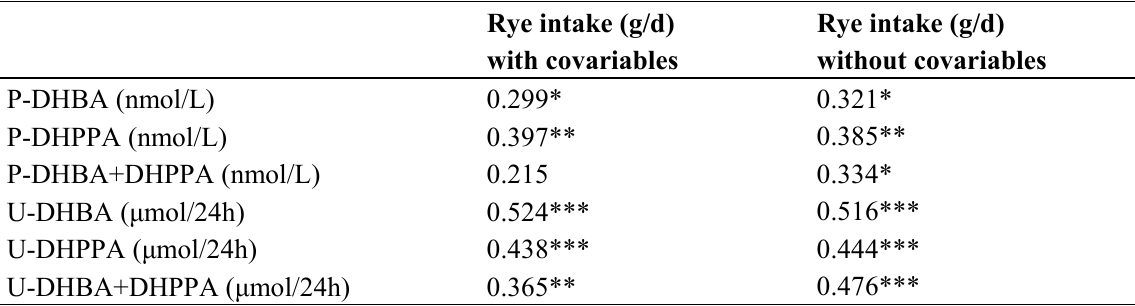
Table 2. Correlation between rye intake and alkylresorcinol metabolites with or without age and body mass index as covariables.